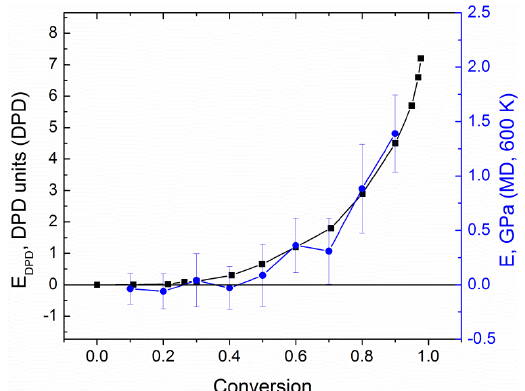
Figure 5. The dynamic mechanical moduli, E’, E”, and mechanical loss coefficient, tan δ , for systems at T = 450 K as a function of the conversion degree. The oscillation frequency varied in the range of 5.3 ∙ 10 8 –5.4 ∙ 10 8 Hz.